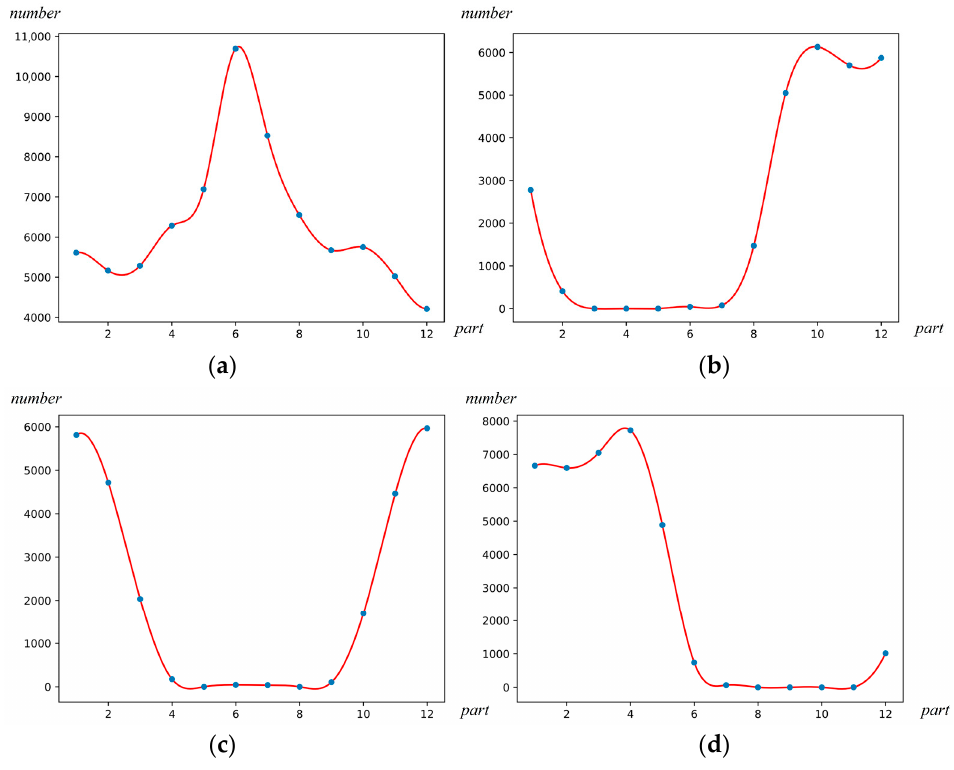
( d ) Figure 9. Schematic diagram of the image segmentation: ( a ) A scene before the object is obscured; ( b ) The scene 1 where the object is obscured; ( c ) The scene 2 where the object is obscured; ( d ) The scene 3 where the object is obscured. The image above shows that the number of bright spots in the segmented area oc- cluded by the mast is significantly smaller than that in the segmented area not obscured by the mast. B is the edge detection image, the resolution of image B is x y p p × , and k is the serial number of the segmented area in image B . k n is the number of bright spots in the k segmented area, x is the horizontal coordinate of the pixel in the image B , y is the vertical coordinate of the pixel in the image B , and k a is the left critical value of the k segmented area in the x direction. The ( , ) bright x y